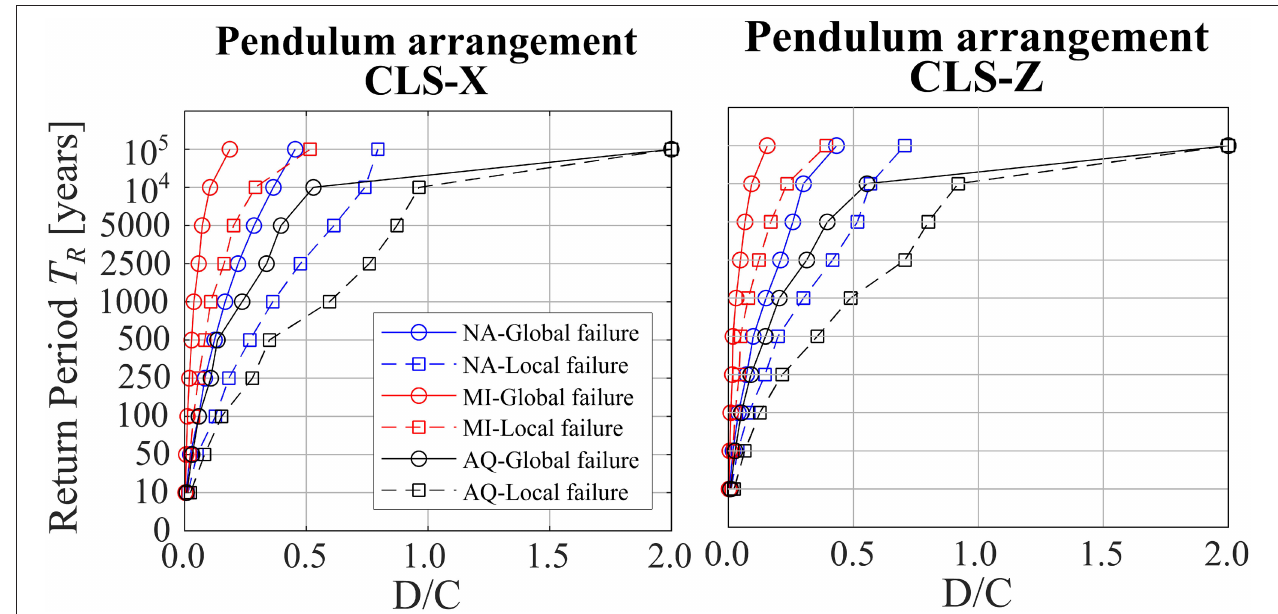
FIGURE 8 | The mean value of D/C ratio with reference to Collapse Limit State for all considered panel arrangement at three considered sites.